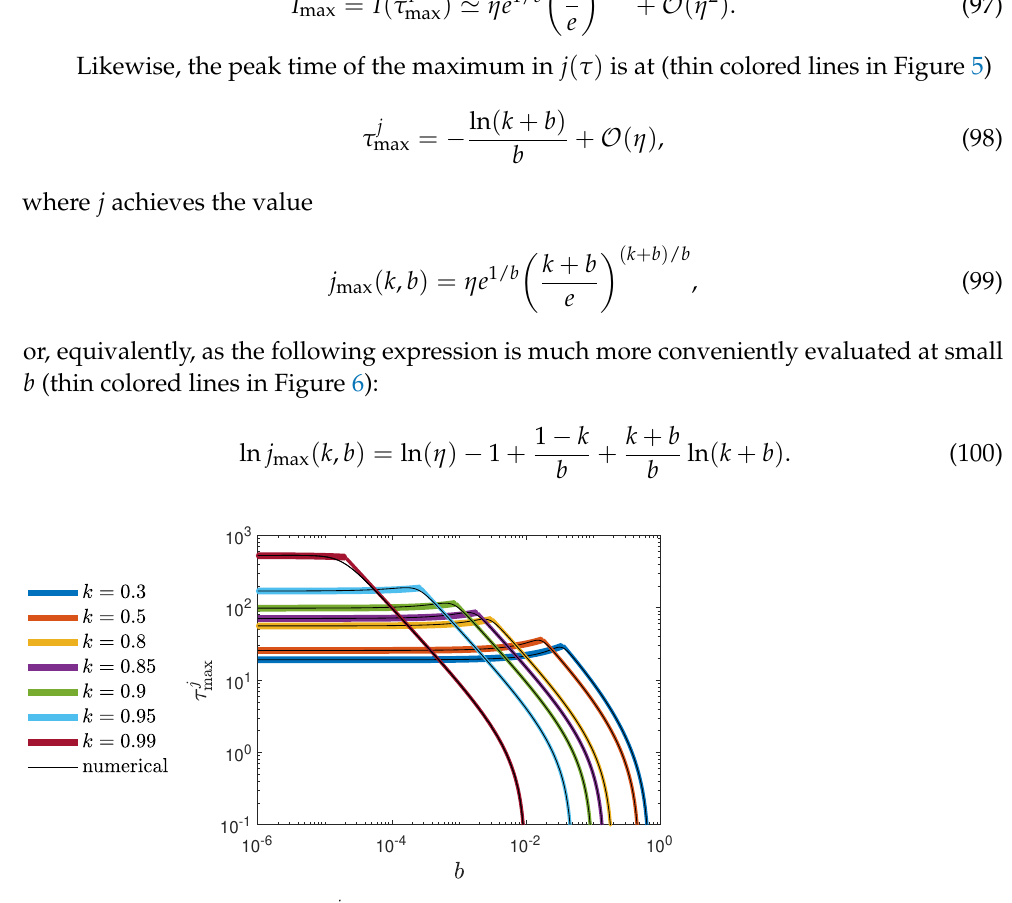
Figure 5. Reduced peak time, τ j max , of the newly infected population fraction, j ( τ ) , versus reduced vaccination rate, b , for various k at η = 10 − 6 (double-logarithmic plot). The exact numerical solution (solid black) is compared with the approximant (98) within the regime of b > b c (thin colored), and by the corresponding linear interpolant (thick colored) for the remaining regime of very small b < b c . The limiting value τ j max ( b → 0 ) exactly coincides with the τ SIR max ( k ) of the SIR model (see Appendix